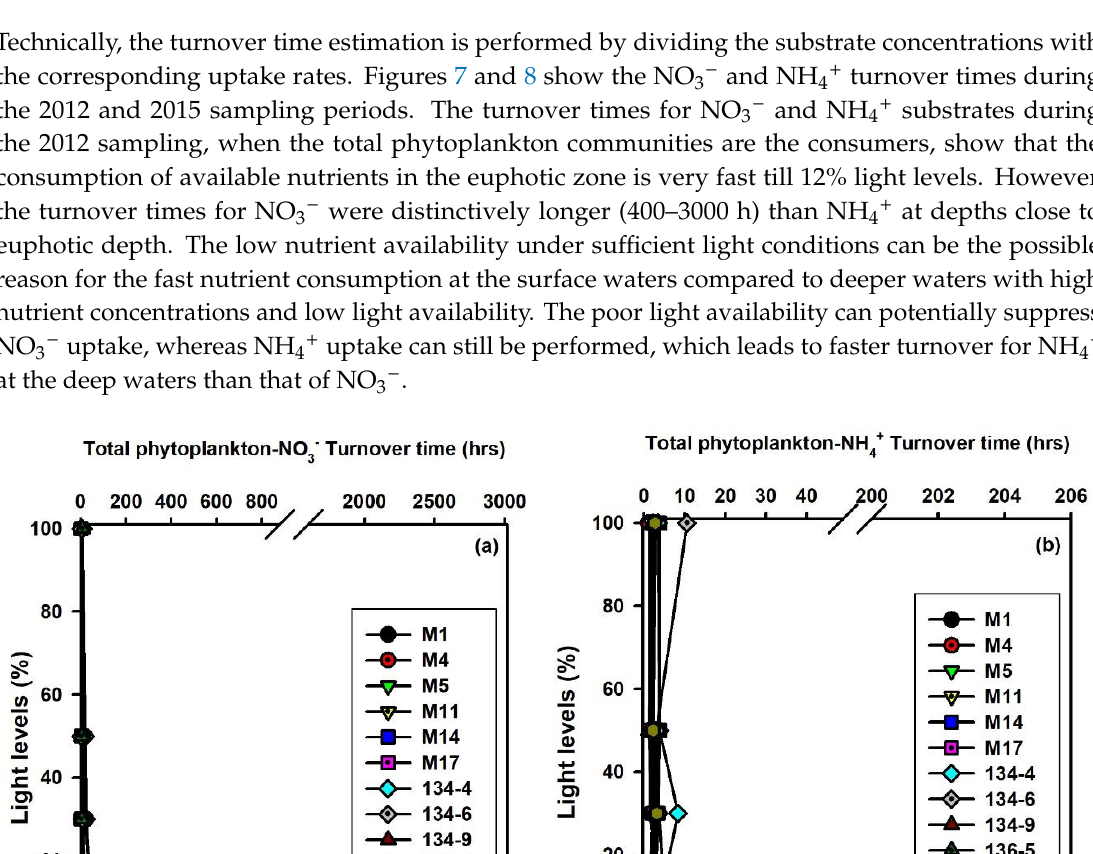
Figure 8. Depth profiles of turnover times of NO 3− and NH 4+ substrates by total and small phytoplankton in the East/Japan Sea during 2015. ( a , b ) denote the NO 3− turnover times by total and small phytoplankton, respectively, and ( c , d ) denote the NH 4+ turnover times by total and small phytoplankton, respectively.